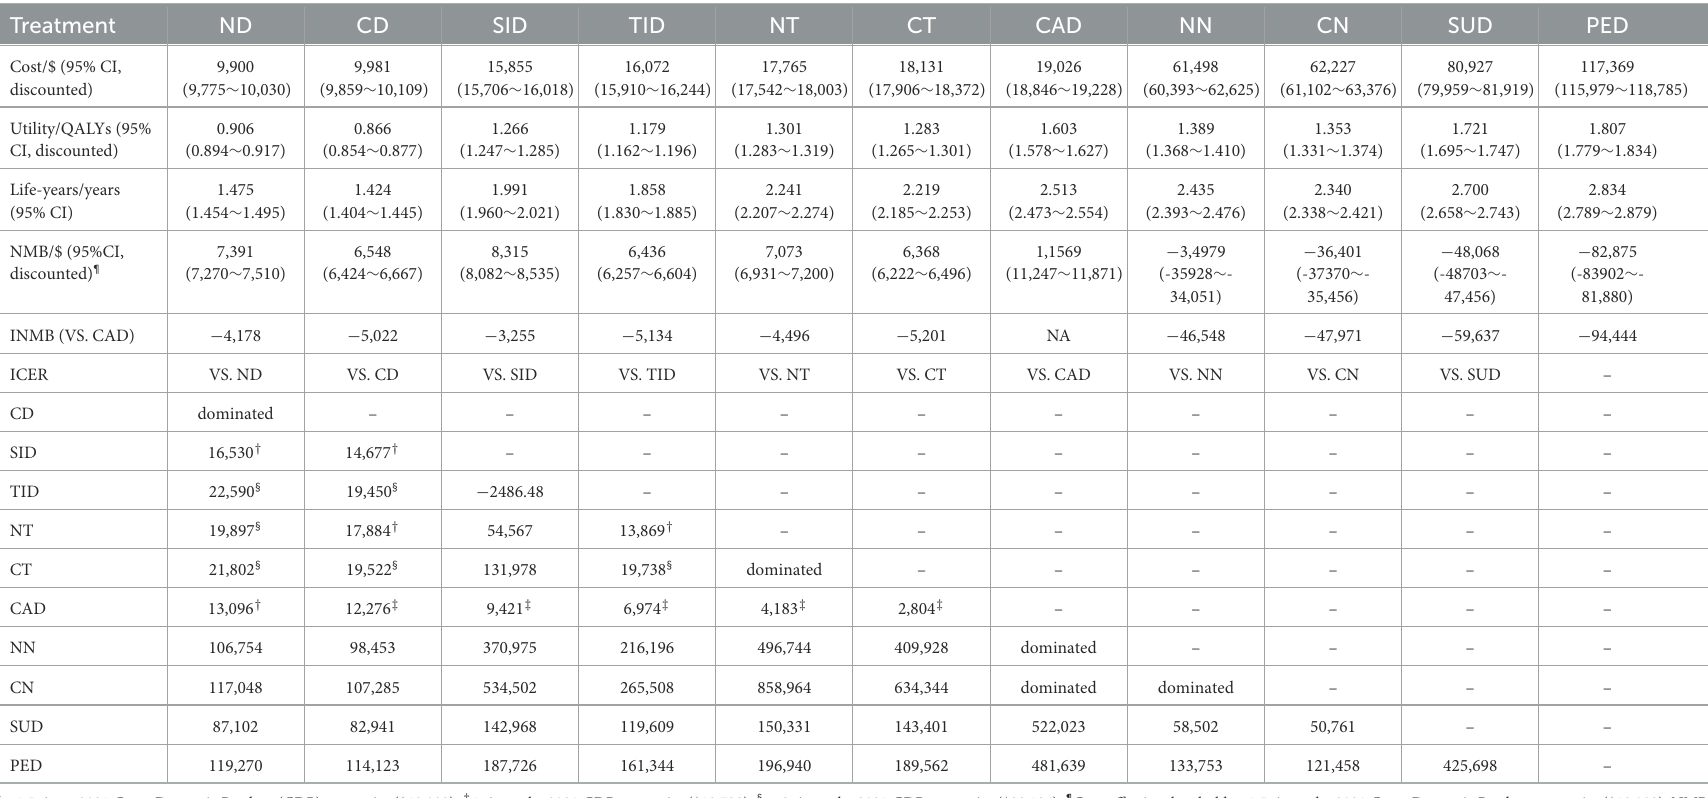
TABLE 2 Base-case analysis